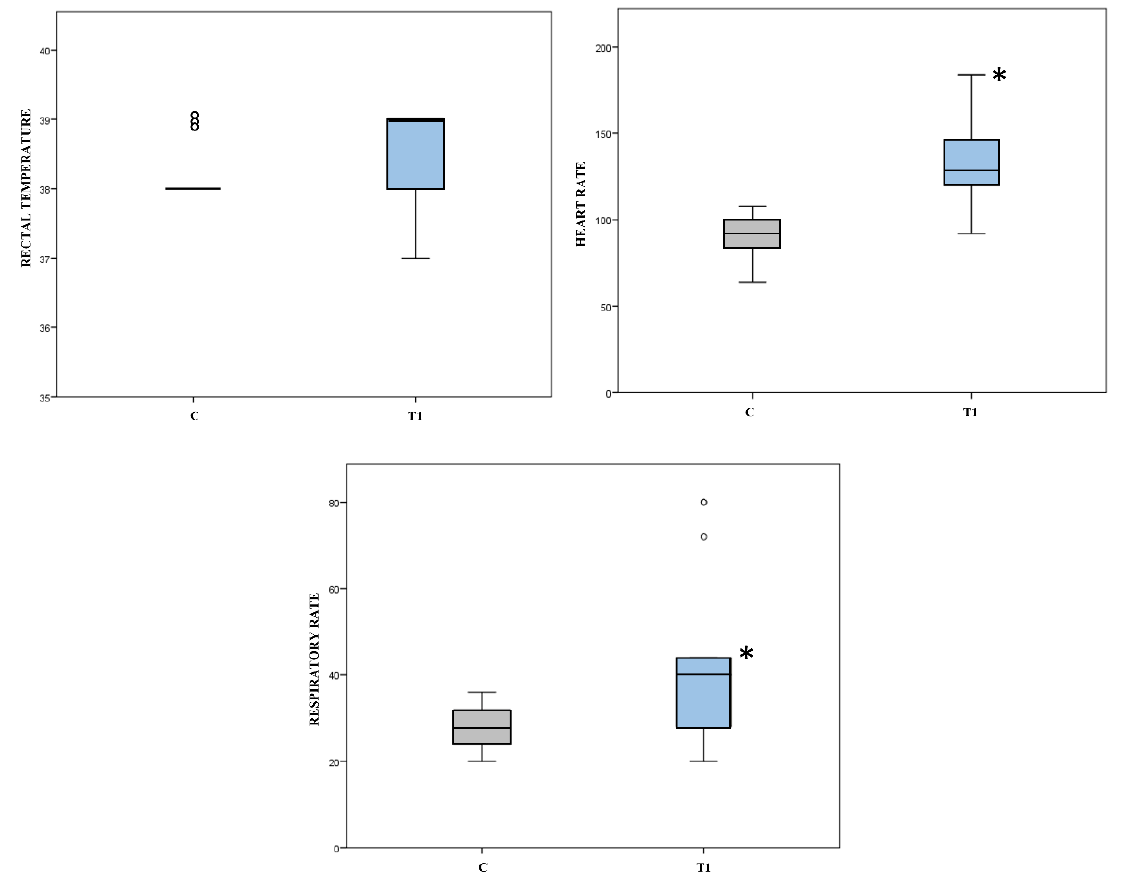
Figure 3. Values of rectal temperature (°C), heart rate (bpm) and respiratory rate (bpm) recorded in 35 healthy pain-free foals (Control Group = C) and in 15 sick foals experiencing pain (T1) at the time of inclusion in the study. Asterisks * indicate a significant difference between groups at inclusion (C vs. T1, Mann Whitney U Test p < 0.05). Outliers are shown as dots °.